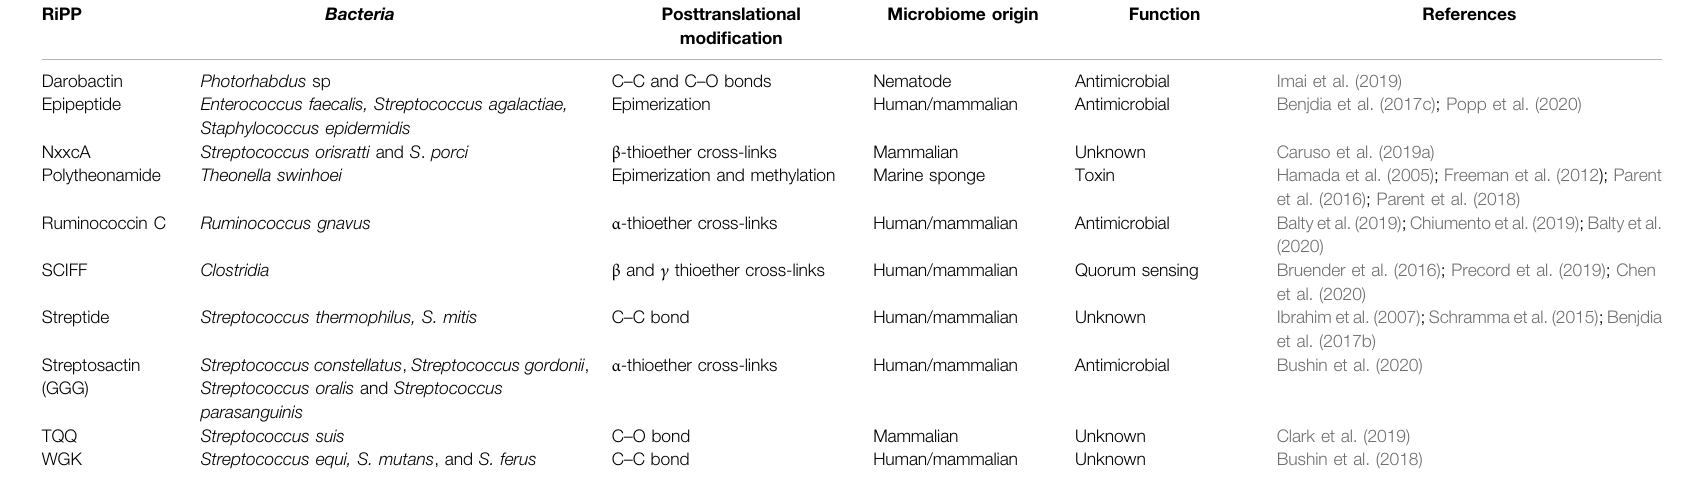
TABLE 1 | RiPPs produced by bacteria from diverse microbiome involving radical SAM enzymes (see Figures 1 , 3 , 6 , 7 for corresponding structures).